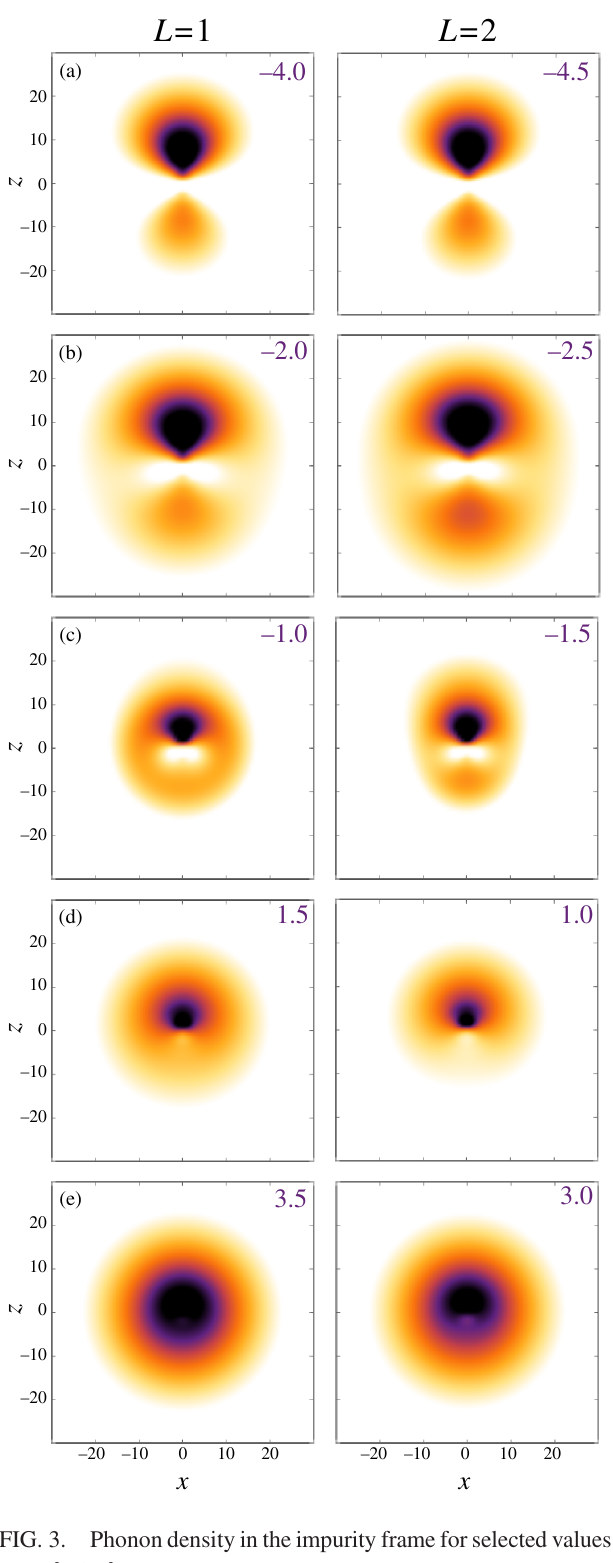
FIG. 3. Phonon density in the impurity frame for selected values oflog ½ B=u 0 (cid:3) ,whicharespecifiedinthe right-hand topcornerofthe panels and (a) – (d) as labeled in Fig. 2; (e) far to the right from the instability, at log ½ B=u 0 (cid:3) ¼ 3 . 5 for L ¼ 1 and at log ½ B=u 0 (cid:3) ¼ 3 . 0 for L ¼ 2 . The coordinates ð x; z Þ are in units of ð mu 0 Þ − 1 = 2 .